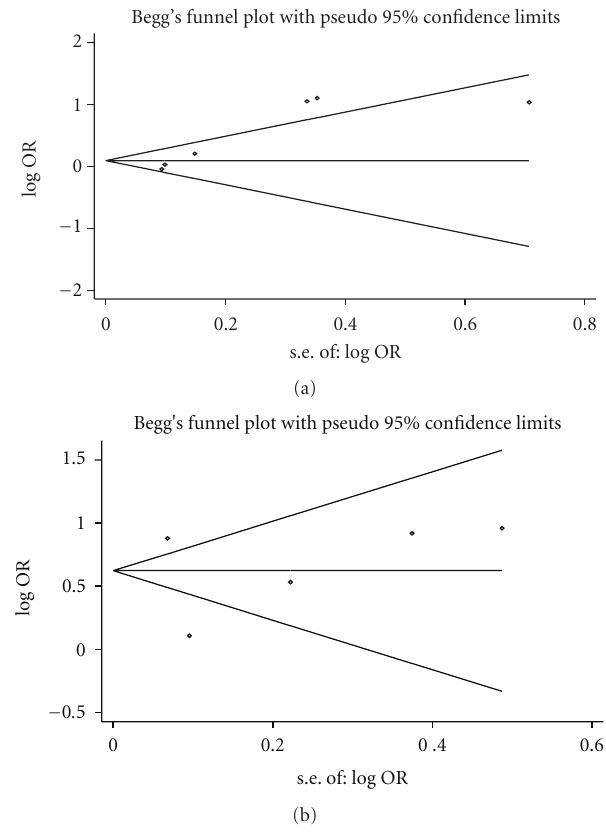
Figure 3: (a) Plot for arsenic concentration as exposure assessment, (b) funnel plot for arsenic concentration and duration as exposure